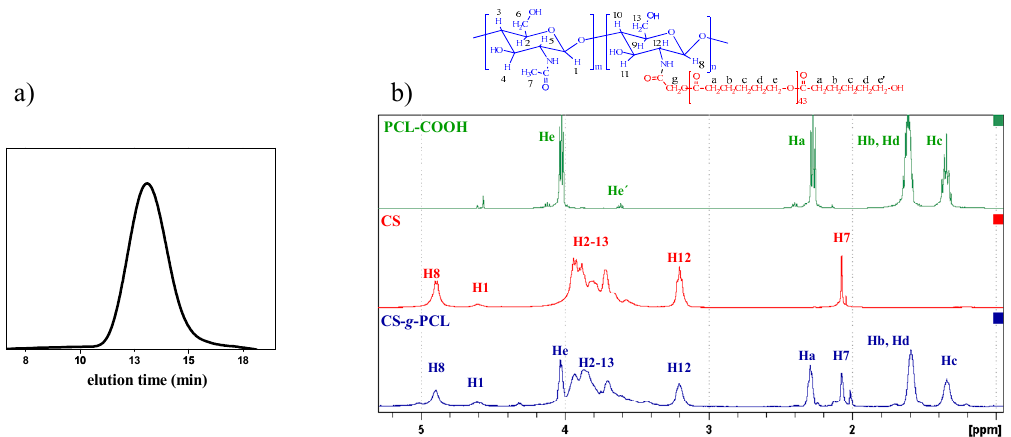
Figure 2. Gel permeation chromatography (GPC) of PCL-COOH ( a ) and 1 H NMR of PCL-COOH, CS, and Cs- g -PCL ( b ).